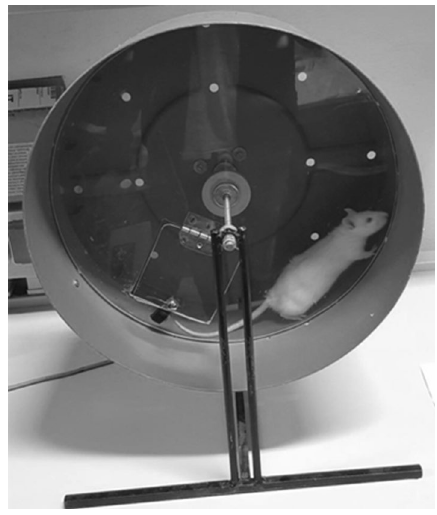
Figure 1. Picture of the training apparatus.